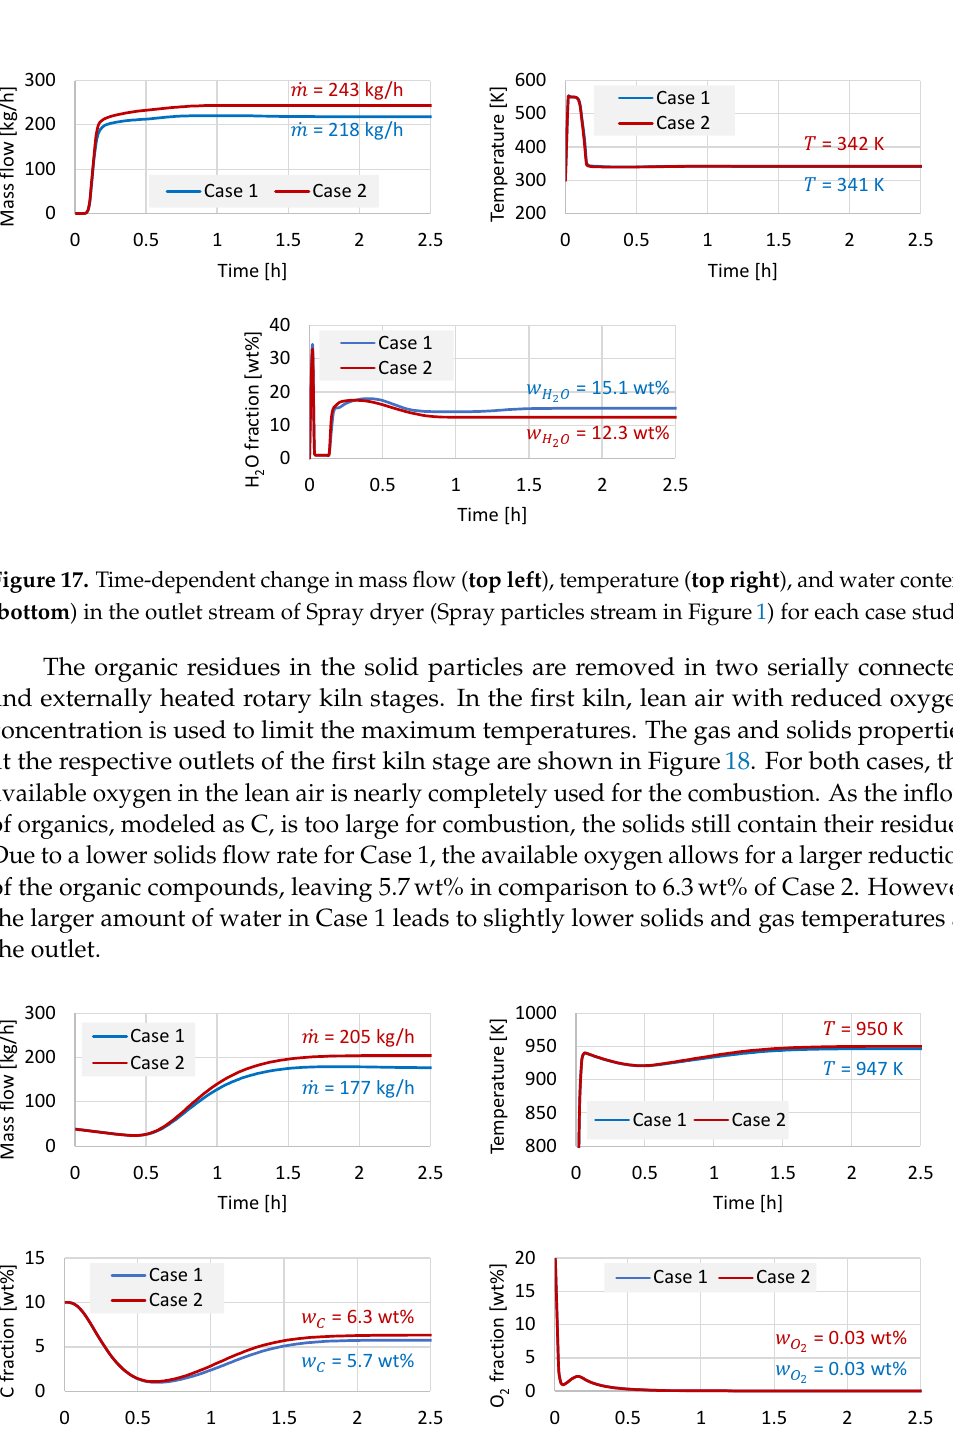
Figure 18. Time-dependent change in mass flow ( top left ), temperature ( top right ), and concentration of organic residues ( bottom left ) in the solids outlet stream of Calciner 1 (Particles stream in Figure1), and change in residual oxygen concentration ( bottom right ) after combustion in the gas outlet stream (Out calciner gas 1 stream in Figure1). For the second calcination stage, ambient air with 21% oxygen is used. Gas and solids properties at the respective outlets of the second kiln stage are given in Figure 19. It is shown, that the larger amount of organic material in Case 2 leads to a lower oxygen content of the air at the outlet of the second kiln. Nonetheless, for both cases, the organic residues are completely removed from the solids after the second